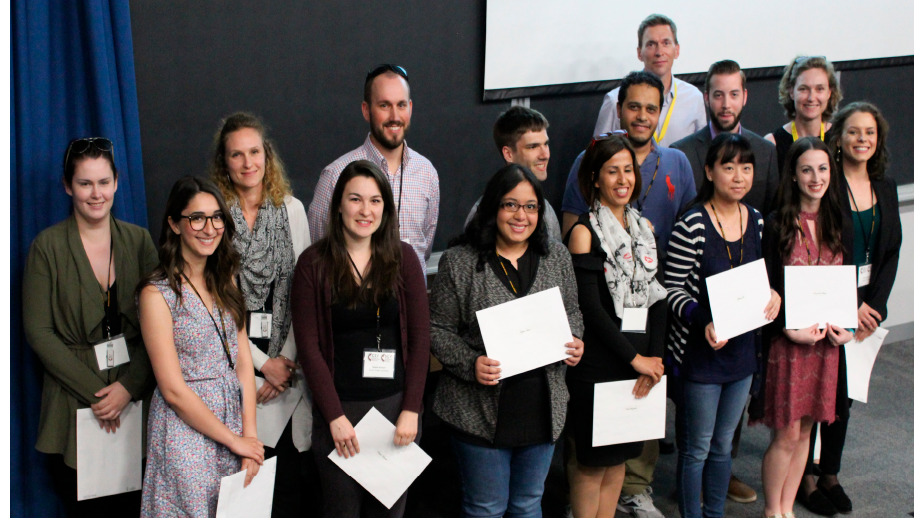
Figure 5. Presentation of travel awards. Each trainee abstract selected for an oral presentation by the